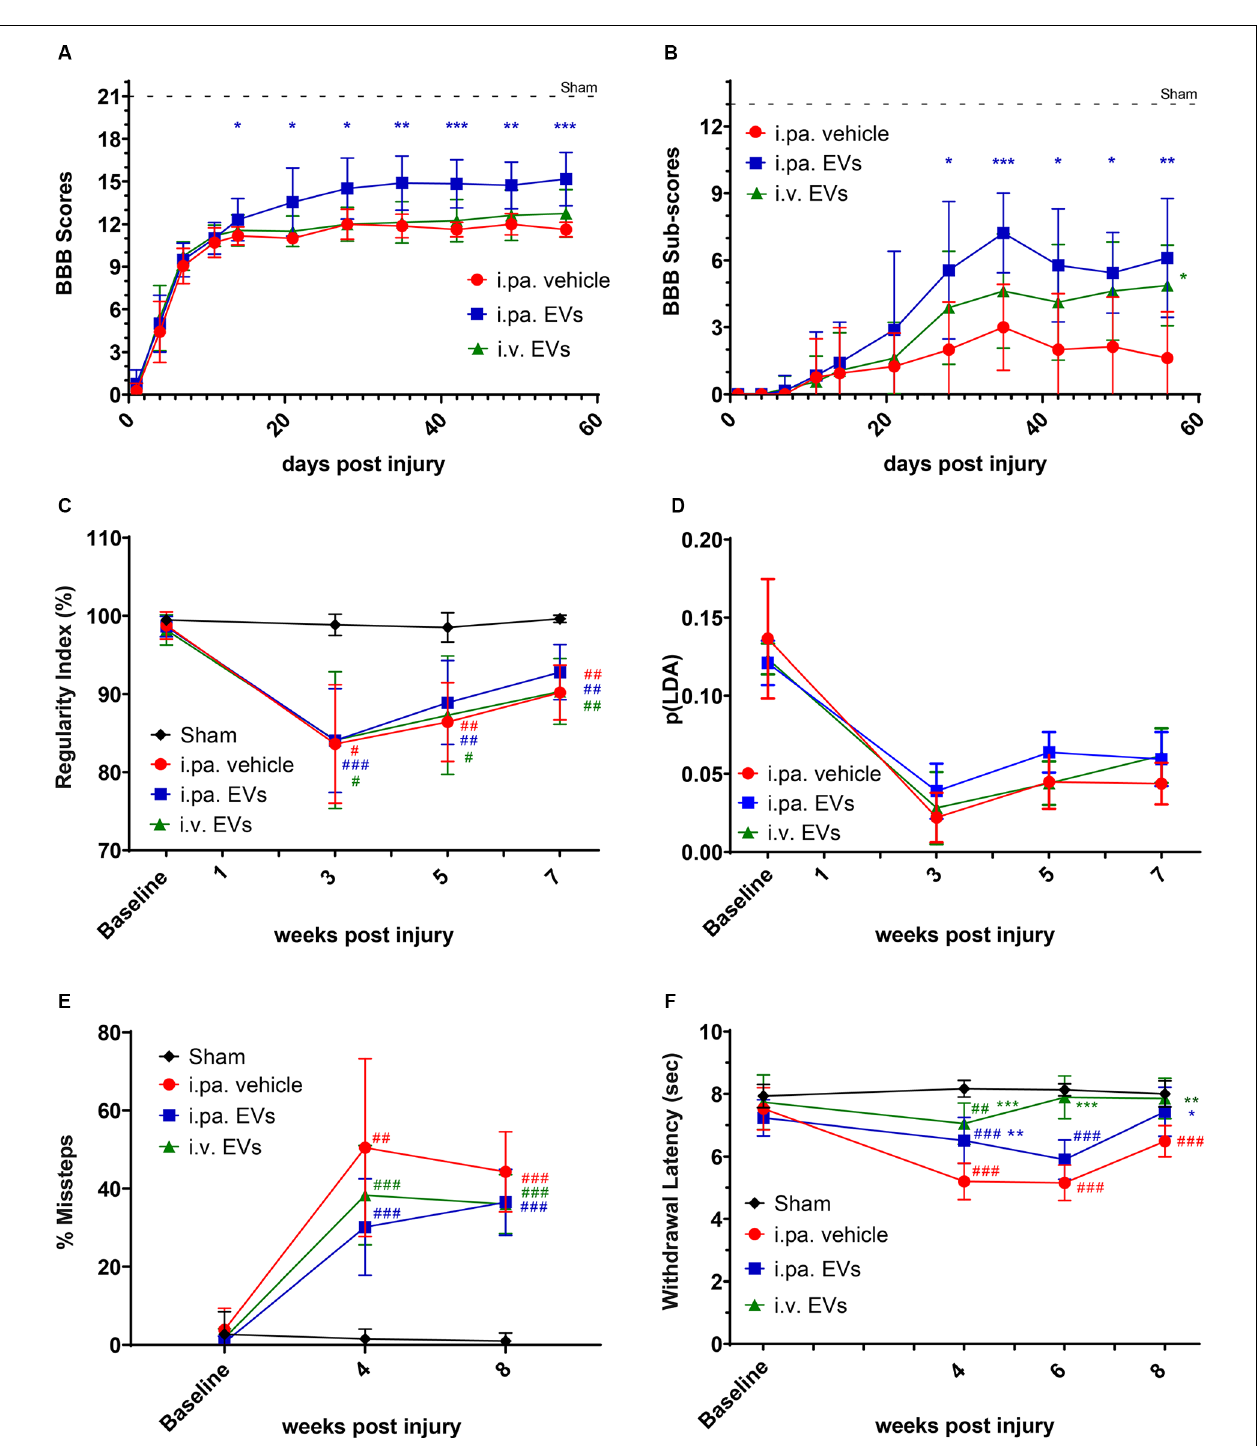
FIGURE 1 | Acute intralesional application of EVs improved functional recovery after tSCI. The locomotor function of rats was monitored by (A) BBB scores and (B) sub-score in the tSCI groups. (C) Inter-limb coordination was assessed by Catwalk regularity index. (D) The p(LDA) was calculated to combine the nine most SCI-affected Catwalk parameters. (E) Skilled walking was tested with the horizontal ladder walk test and the percentage of step cycles containing missteps was monitored over time. (F) Thermal sensitivity was assessed according to the withdrawal latencies to a thermal stimulus using the plantar test Hargreaves’ method. Statistical differences to sham group using two-way ANOVA and Tukey post hoc test: ( # ) p < 0.05, ( ## ) p < 0.01, ( ### ) p < 0.001, statistical differences to i.pa vehicle group using two-way ANOVA and Tukey post hoc test on tSCI groups (without sham): ( ∗ ) p < 0.05, ( ∗∗ ) p < 0.01, ( ∗∗∗ ) p < 0.001. EVs, extracellular vesicles; tSCI, traumatic spinal cord injury; BBB, Basso-Beattie-Bresnahan.